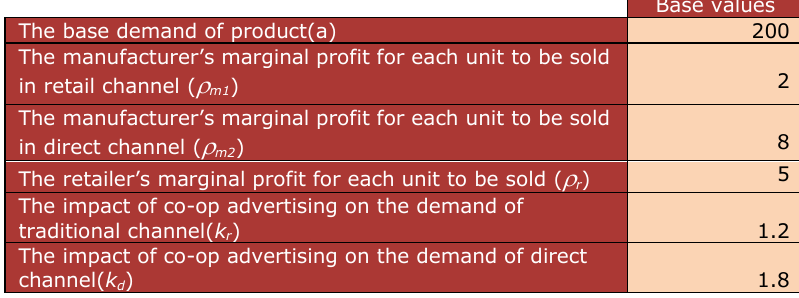
Table 1. Parameters setting in our numerical